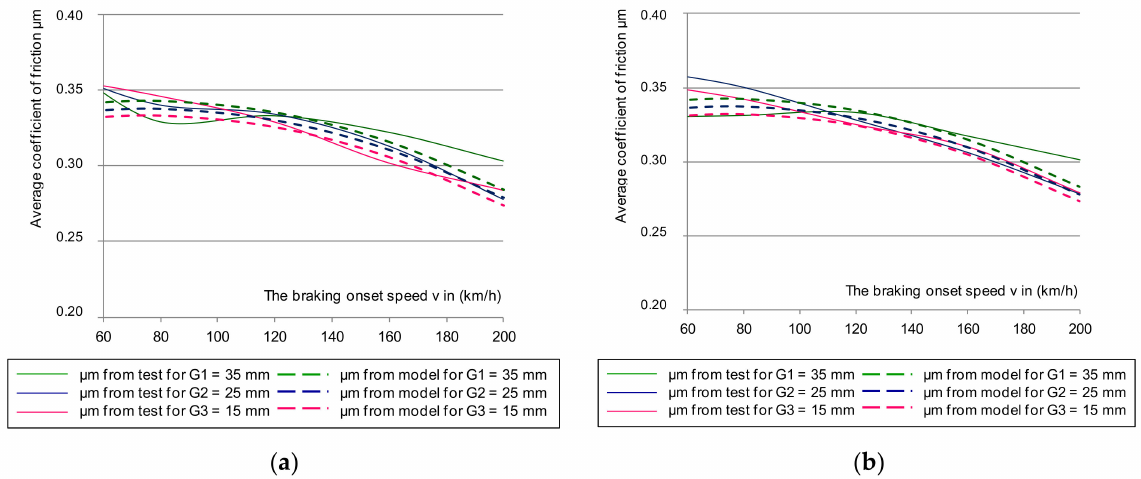
Figure 17. The changes of µ m from the tests with multiple regression model during braking on a worn disc type 640 × 110 z: ( a ) N = 28 kN and M = 6.7 t, ( b ) N = 40 kN and M = 6.7